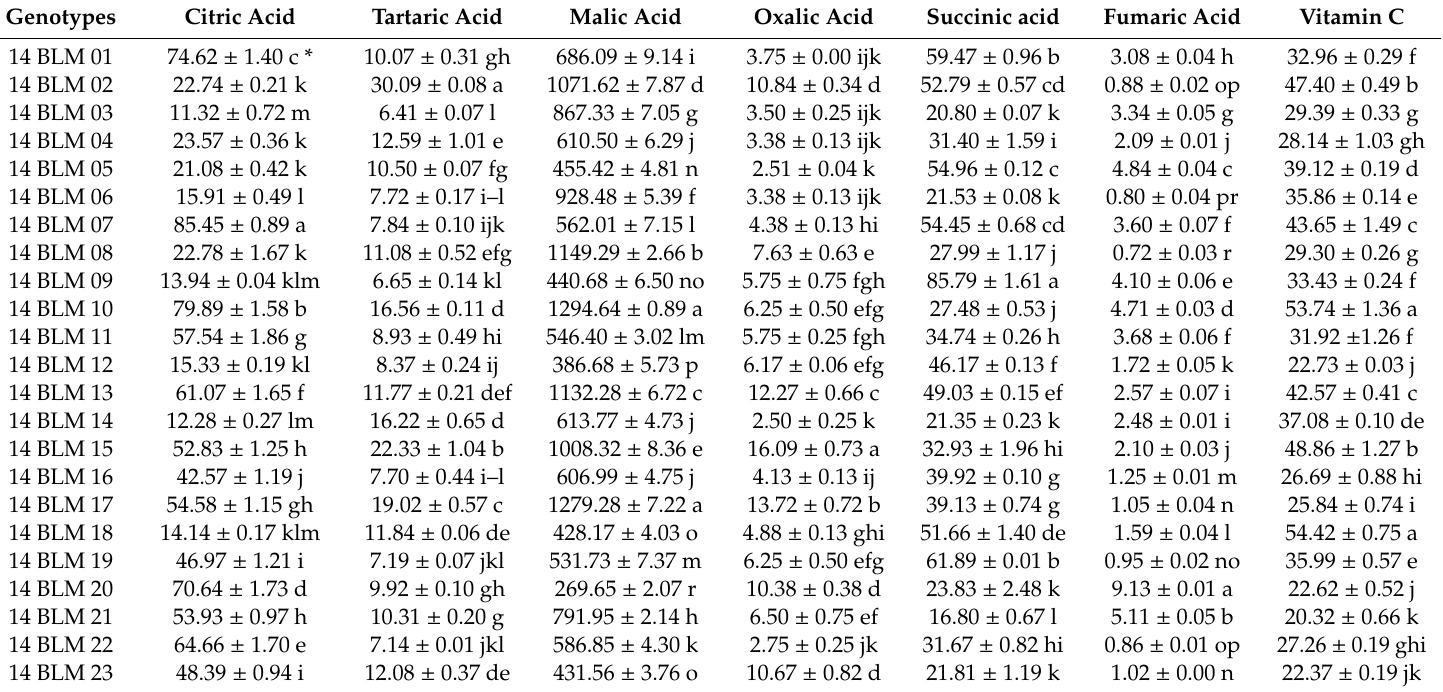
* : Di ff erent letters in columns indicate significantly di ff erent values at p ≤